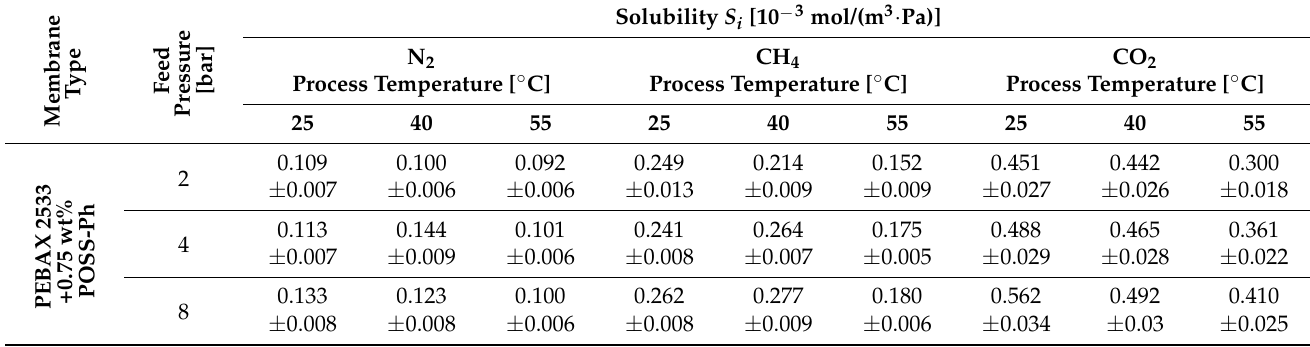
Table A12. Solubility coefficient of heterogeneous membranes containing POSS-Ph to different gases measured for different feed pressure and temperature